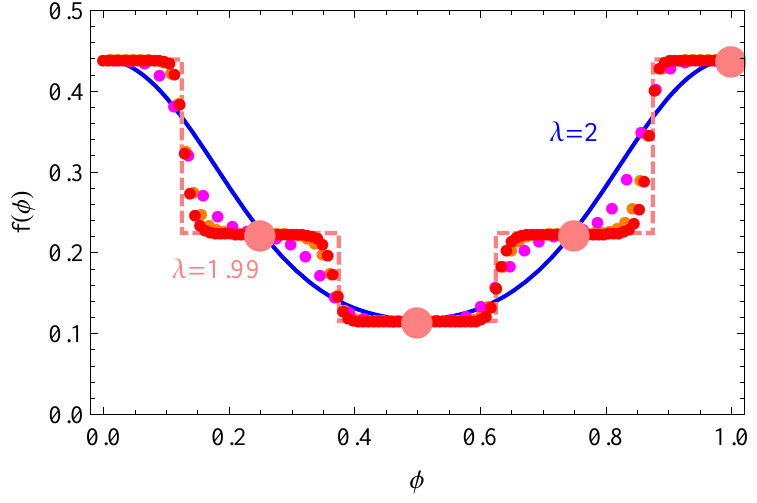
Figure 10: Envelope functions defined by Eq. (105) at the integrable point λ = 2 (continuous blue curve) and computed numerically at λ = 1.99: the points for c = 11 / 43,21 / 83,31 / 123 (magenta, orange, red) converge onto the limit envelope function of c = 1 / 4 (discontinuous dashed line at the limit). The four points for c = 1 / 4 at λ = 1.99 are also shown (large pink points). Here p = 0.02, ξ = 1.